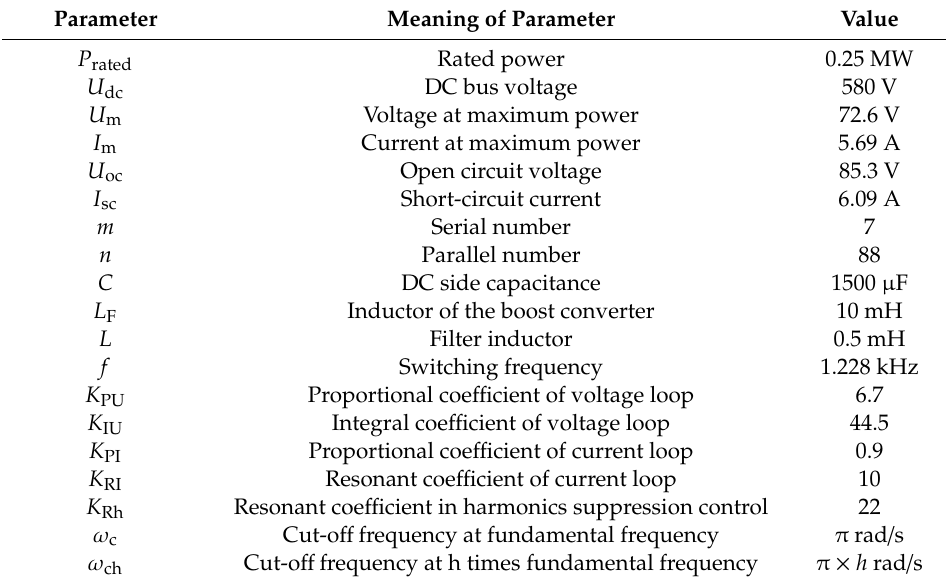
Table 5. Simulation parameters.